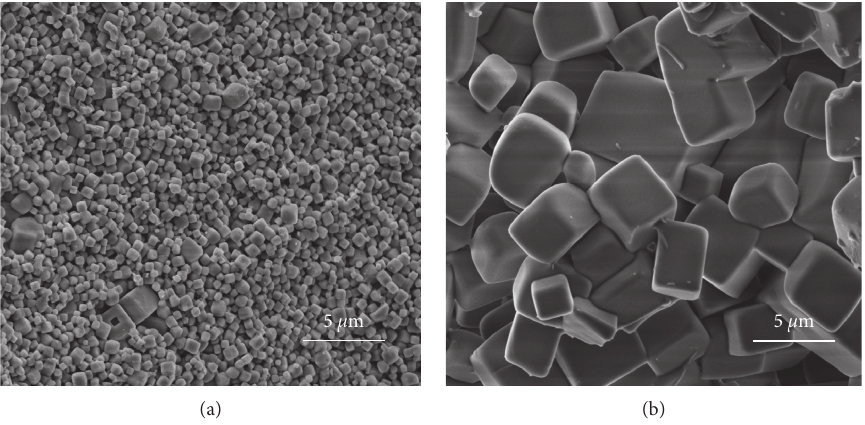
Figure 3: SEM micrographs of (a) NaCl-TiO